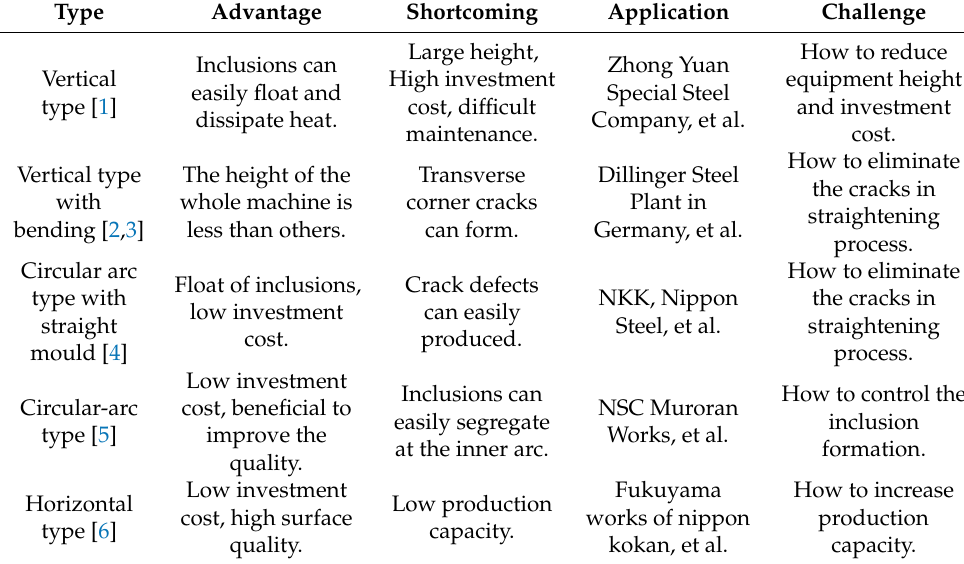
Table 1. The different continuous casting